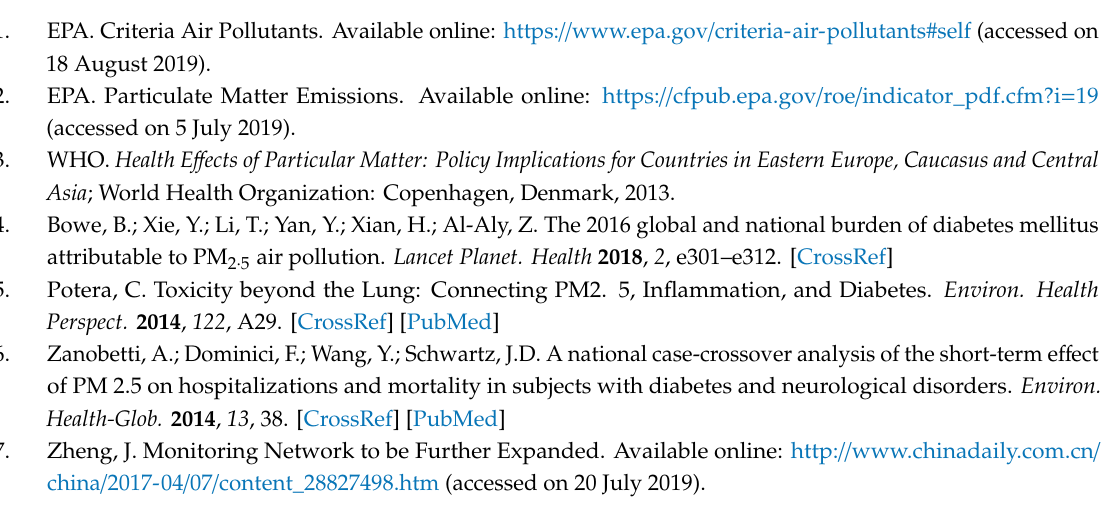
Figure S1: Learning curves of scaling (slope) and shift (intercept) factors for relative humidity and PBLH, Figure S2: Scatter plots of the observed vs. predicted PM 2.5 in univariate linear regression, illustrating improvement of the optimal ACG by automatic di ff